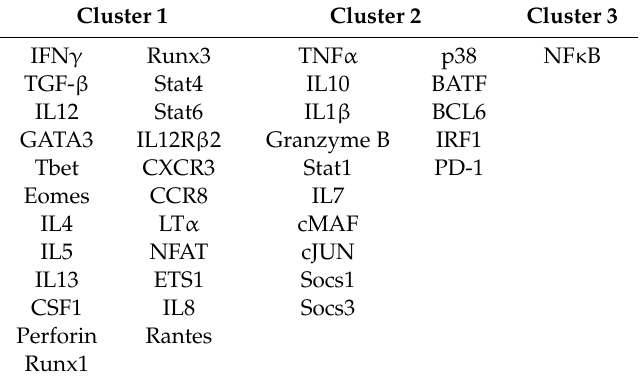
Table 3. Di ff erential clustering of TF’s and cytokines based on their similar expression order.